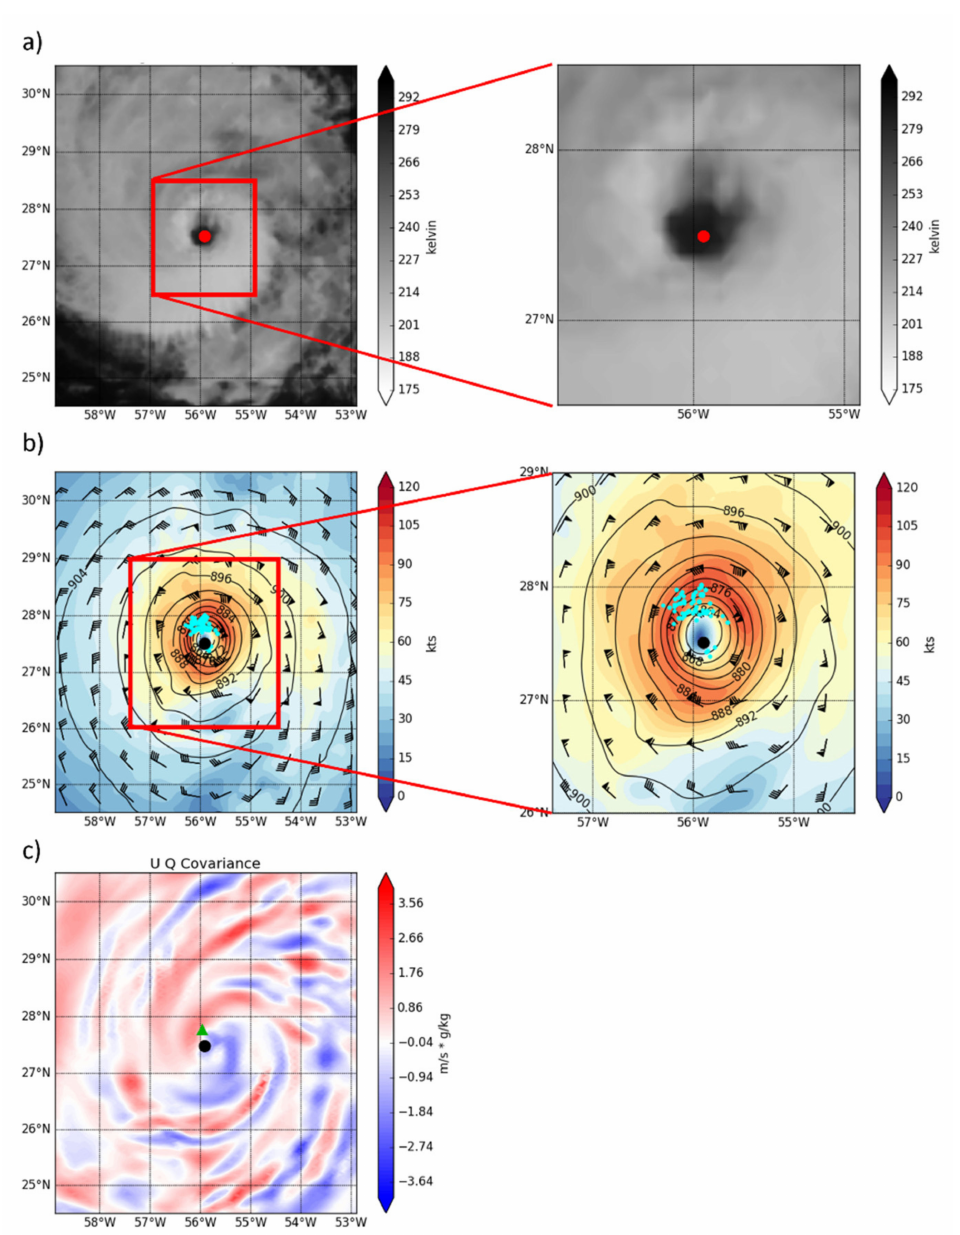
Figure 13. ( a ) GOES 13 long wave infrared Satellite imagery with TCVital (red) overlaid. ( b ) 1H- 3DEnVar E2 at 1700 UTC wind analysis (colors and barbs) overlaid with wind speed increments > 10 m/s (blue dots) and TCVital (black). ( c ) 1700 UTC 1H-3DEnVar Ensemble cross-covariance between U wind speed and specific humidity (Q) for a sample observation (green triangle) corre- sponding to the region of large innovations. TCVital overlaid (Black